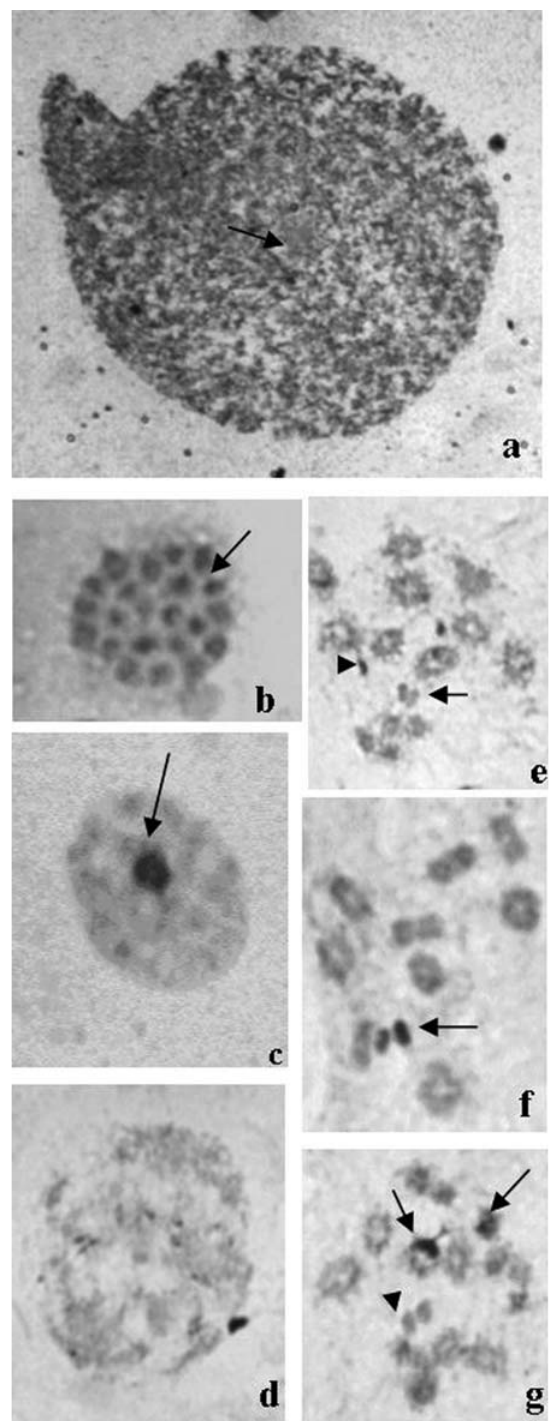
Figure 4 - Silver-impregnated testis tubules of Triatoma klugi : (a) Poly- ploid nuclei of nutritive cells of tubule wall with a silver stained nucleolus indicated by arrow; (b) Spermatogonial metaphase with chromatin fibers joining the chromosomes indicated by arrow; (c) Spermatocytes, the ar- row indicates a silver stained nucleolus; (d) Nucleus in prophase I with a peripheral nucleolar corpuscle; (e) Diplotene, the arrow indicates the sex pseudobivalent. Note the nucleolar corpuscle shown by the arrowhead; (f) Diakinesis, arrow shows the silver stained sex pseudobivalent; (g) Nu- cleus in diplotene-diakinesis, silver stained autosomes are indicated by ar- rows and arrowhead indicates unimpregnated sex